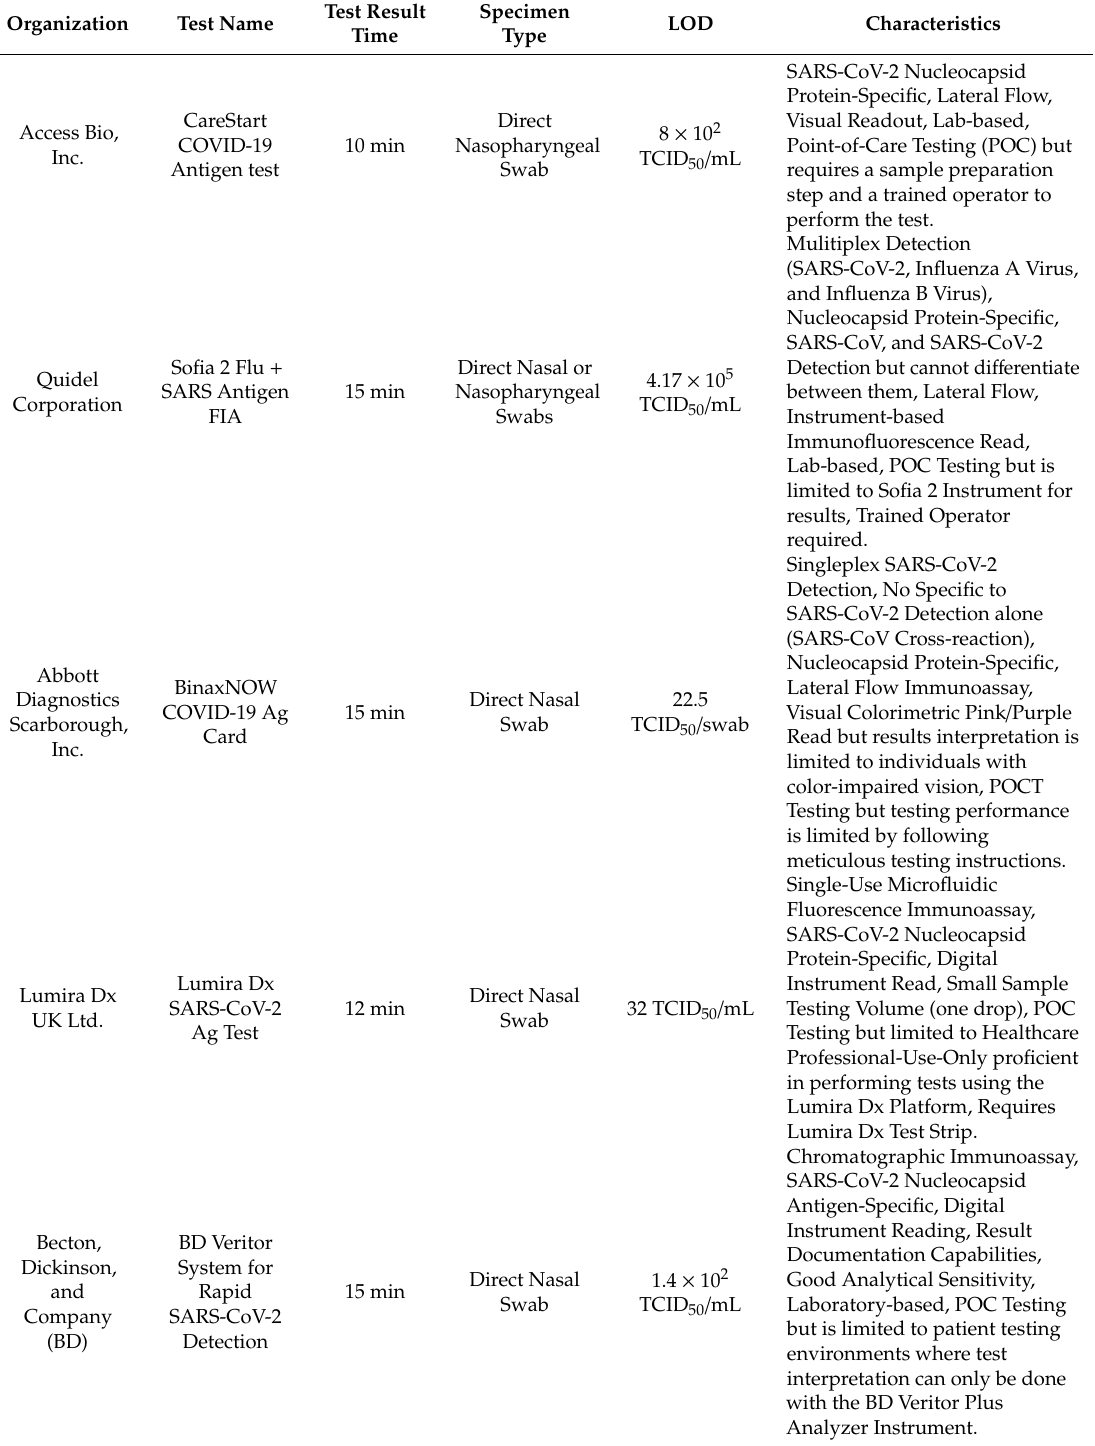
Table 3. Summary of most recent Emergency Use Authorization (EUA) issued antigen tests for SARS-CoV-2. All the information is collected from the Food, Drug and Administration (FDA)